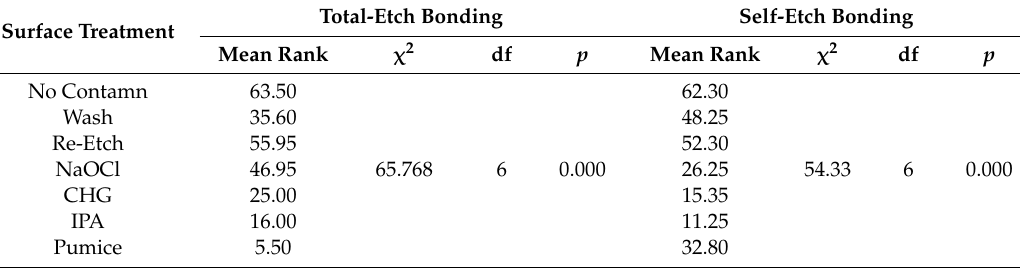
Table 3. Kruskal–Wallis analysis on SBS measured on di ff erent